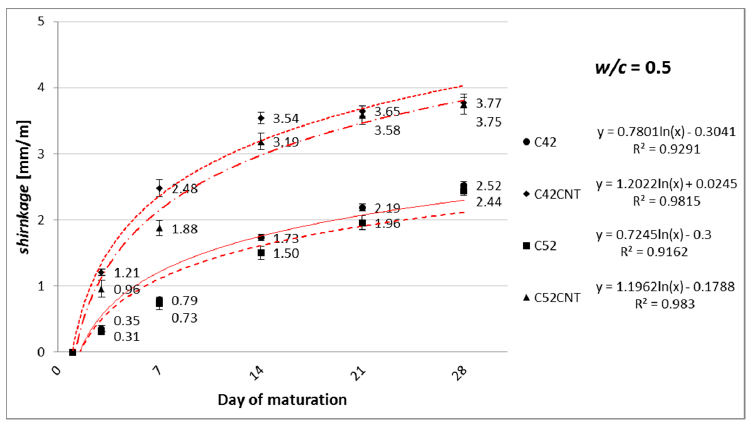
Figure 6. Increase in linear shrinkage of modified cement paste with w / c = 0.5, as a function of maturation time.